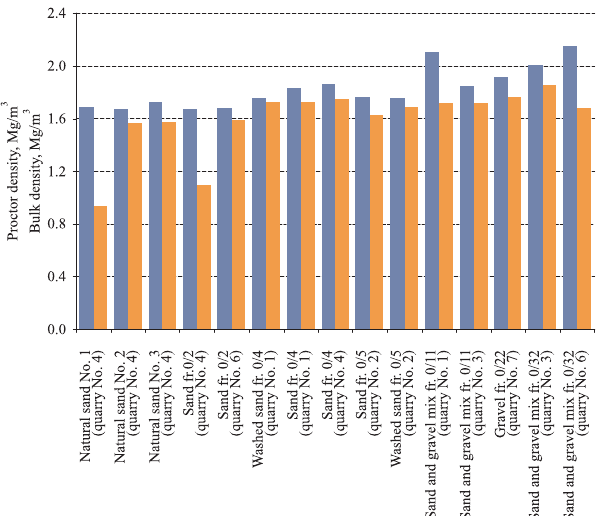
Fig. 2. Results of the Proctor test (Proctor density) and the bulk density test of sand, gravel and their mix